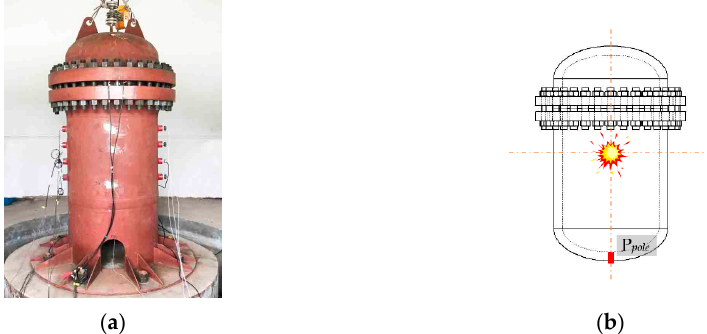
Figure 1 . ( a ) Physical picture of the cylindrical explosion containment vessel; ( b ) Position of the pressure-measuring point (red rectangle).